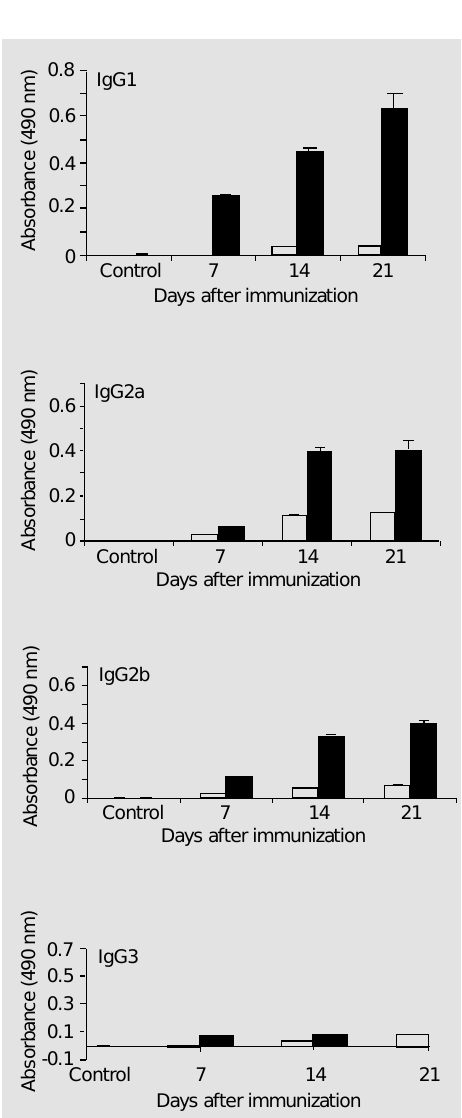
Figure 5 - Distribution of anti- BCG antibodies among immu- noglobulin classes and IgG iso- types. Blood samples were col- lected 21 days after iv immuni- zation with 1.5 x 10 6 CFU of O- BCG (open columns) or ID-BCG (filled columns). Anti-BCG anti- bodies were detected by ELISA using specific monoclonal anti- bodies anti-immunoglobin iso- types as probes. Each point rep- resents the mean ± SD of tripli- cate readings of the sera diluted 1/1000 (O-BCG) or 1/4000 (ID- BCG).